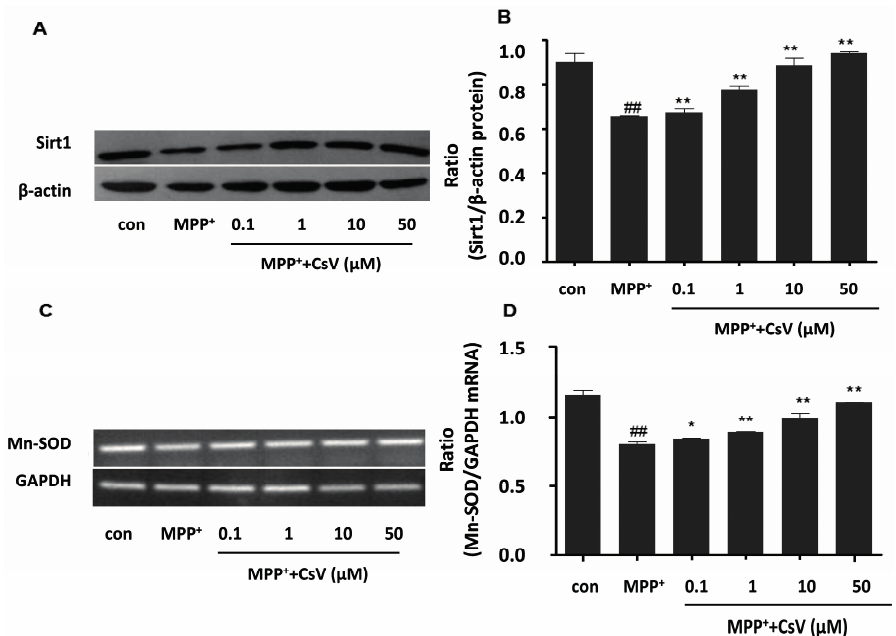
Figure 4. CsV promoted Sirt1 protein and Mn-SOD mRNA expressions in MPP + -treated SH-SY5Y cells. ( A ) Western blot analysis of Sirt1 and β -actin protein levels; ( B ) Data quantification of panel ( A ). Western blot was quantified and expressed as the ratio of Sirt1 and β -actin intensity; ( C ) Polymerase chain reaction (PCR) analysis of Mn-SOD and glyceraldehyde-3-phosphate dehydrogenase (GAPDH ) mRNA levels; and ( D ) Data quantification of panel ( C ). PCR was quantified and expressed as the ratio of Mn-SOD and GAPDH intensity. ## p < 0.01 vs. control group, * p < 0.05, ** p < 0.01 vs. MPP + treated alone. Data are expressed as means ± SD ( n =